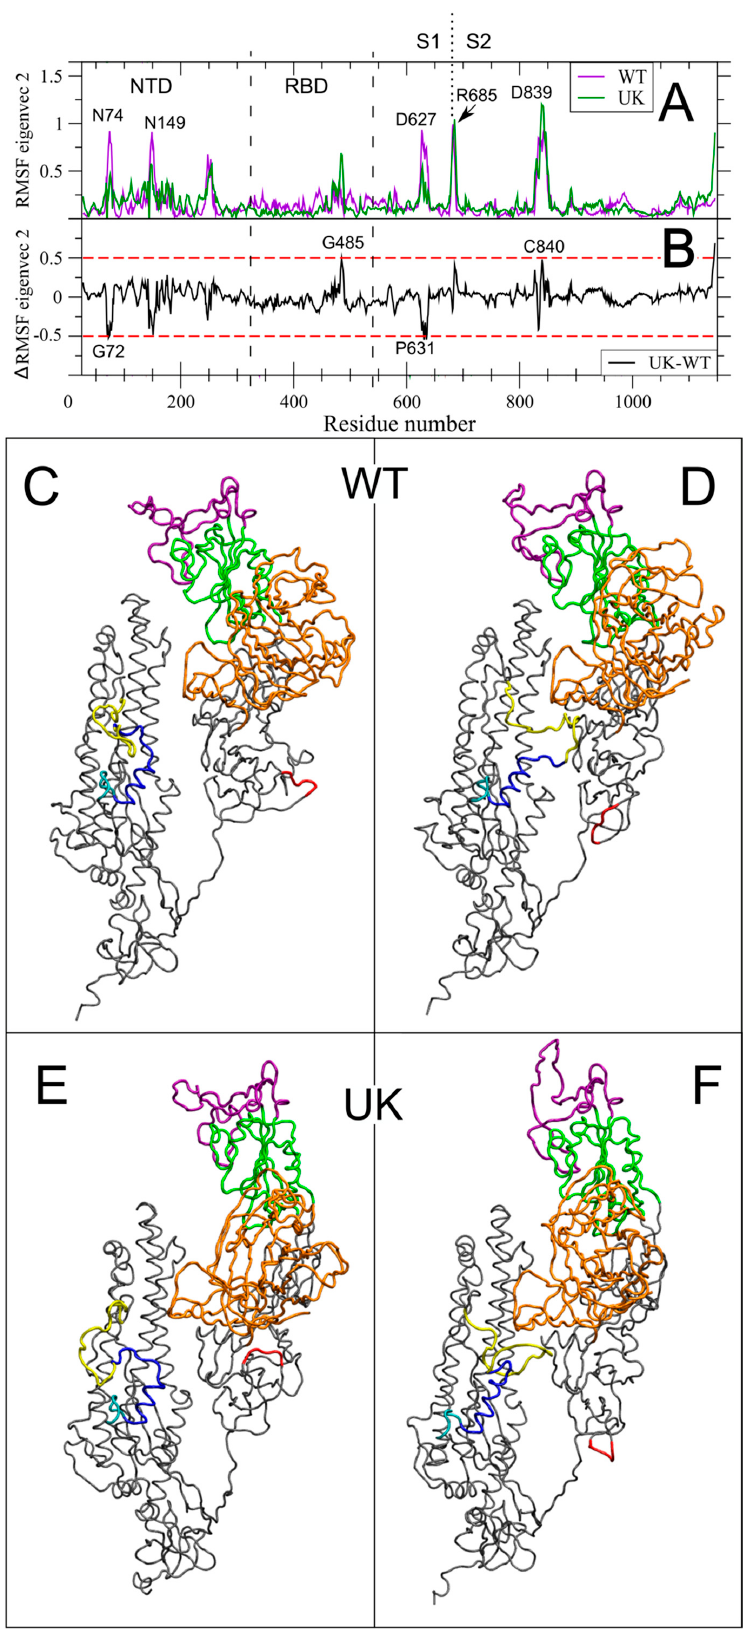
Figure 4. Long-range correlated motions along Essential Dynamics V2. ( A ) Per-residue Root Mean Square Fluctuations (RMSF) in nm of the S protein filtered trajectory along V2 for WT and UK